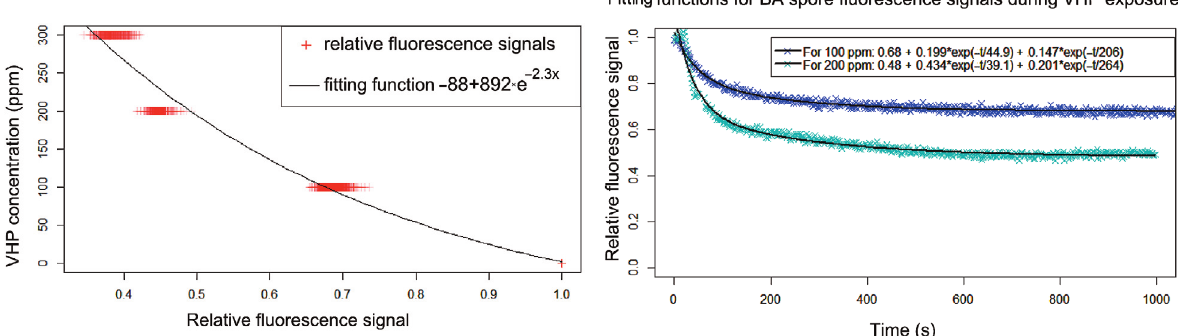
Fig. 7. Left graph – BA spore’s relative fluorescence signal intensity plotted as a function of VHP concentration. Right graph – relative fluorescence signal intensity as a function of time at 100 ppm (blue) and 200 ppm (cyan) VHP concentrations. The values of the biexponential fitting are shown in the top-right corner.